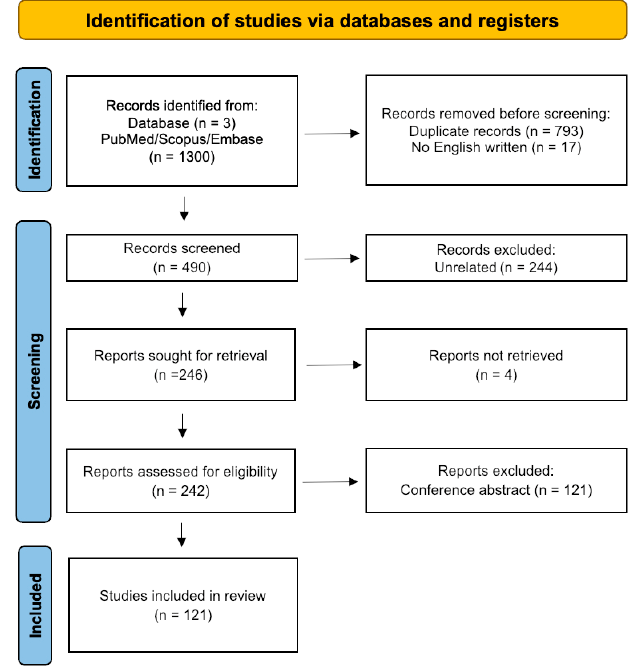
Figure 1. PRISMA flow diagram showing the flow of information through the different phases of the systematic review.